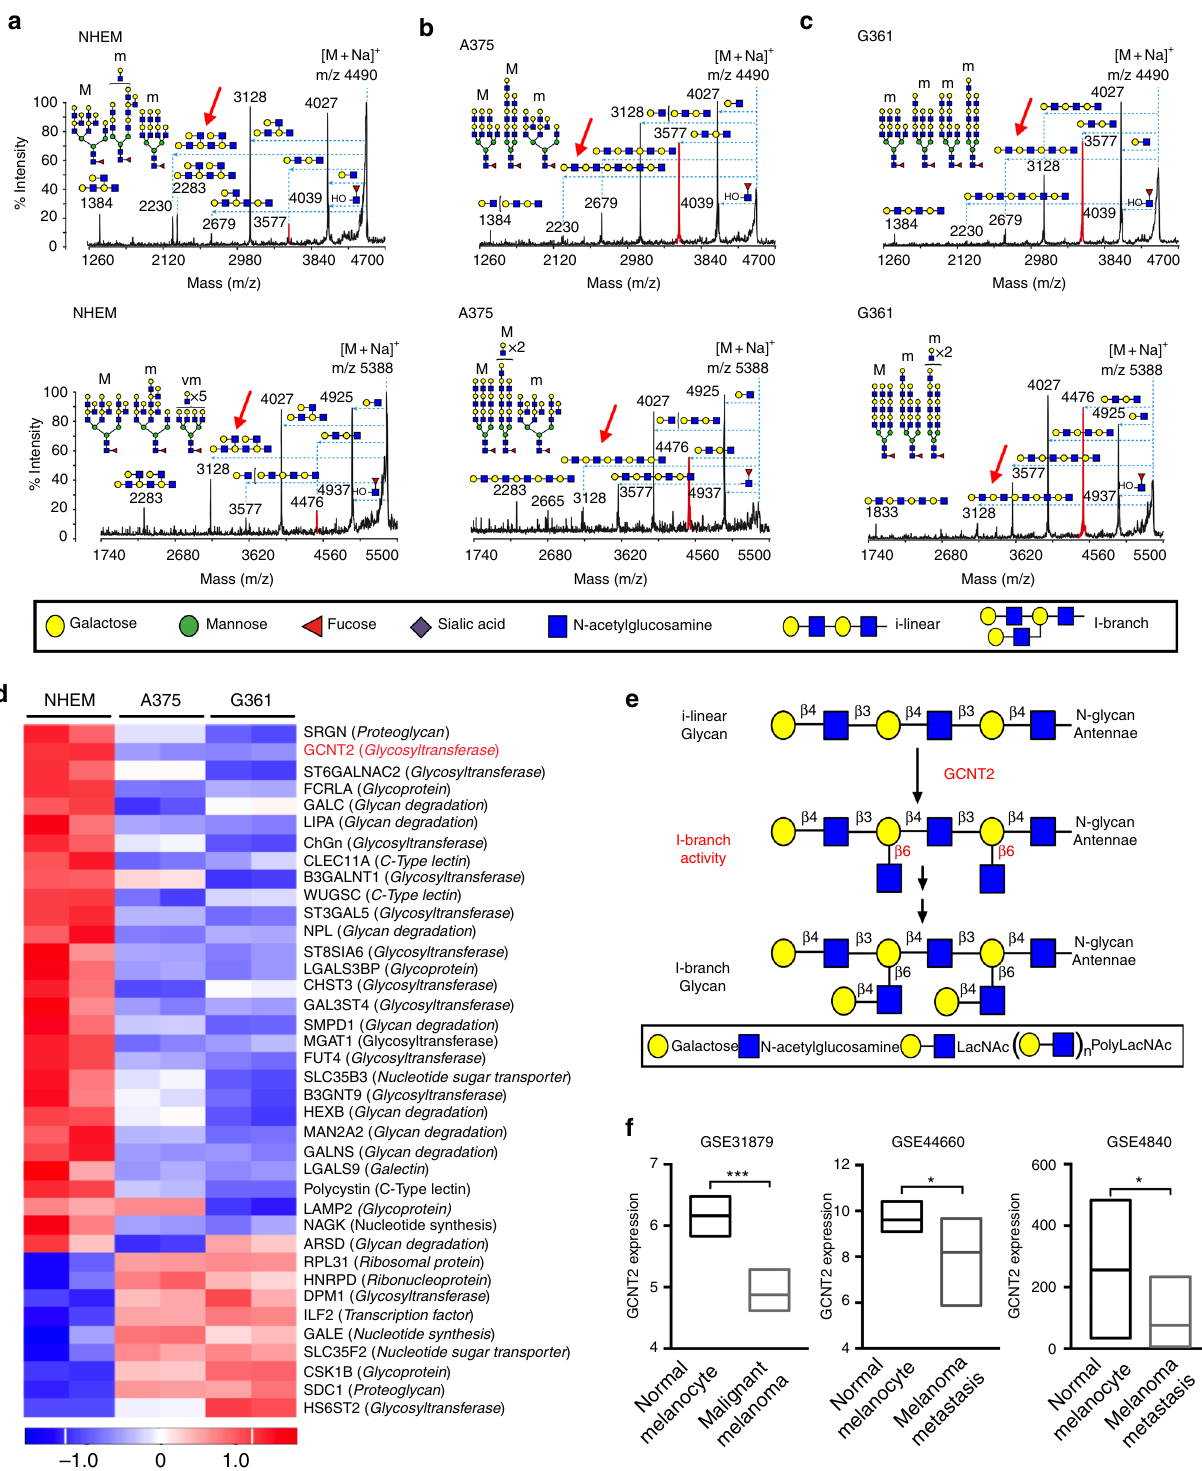
Fig. 2 Human melanomas downregulate I-branching glycosyltransferase, GCNT2. a – c MALDI-TOF-TOF MS/MS on high mass spectra from NHEM ( a ), A375 ( b ), and G361 ( c ) human melanoma cells. All parent spectra and ionized subspectra were graphed as % relative intensity and, for clarity, only major ions ([M + Na] + ) were shown. Cartoon structures were drawn according to http://www.functionalglycomics.org guidelines. Experiments were repeated on (2) different biological replicates. d Heatmap of differentially expressed glycosylation gene transcripts between NHEMs and A375 or G361 human melanoma cells. Statistical analysis was done with limma, and Benjamini – Hochberg correction was used to adjust the p values. Only genes with absolute fold change > 2 and adjusted p value < 0.05 were considered as differentially expressed. e Schematic representation of GCNT2 I-branching activity. f Box plots illustrating downregulation of GCNT2 in clinical melanoma specimens compared to normal melanocytes in multiple datasets. Statistical analysis was done using unpaired two-tailed Student ’ s t test. Mean is representative line inside the box. See also Supplementary Figs. 1,